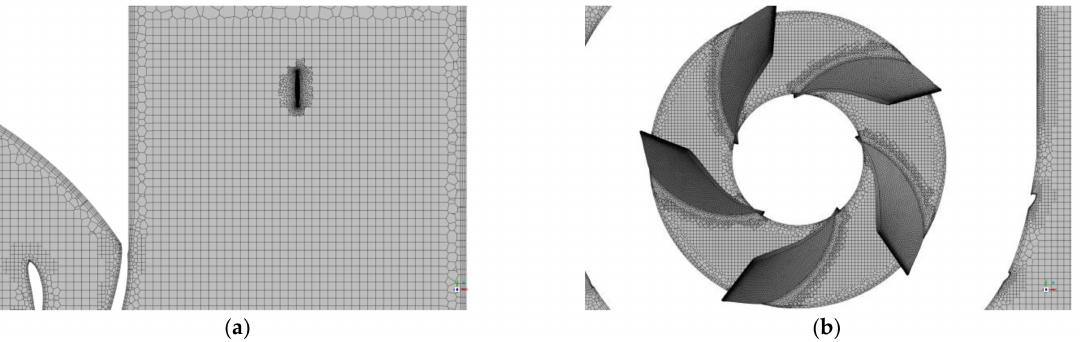
Figure 7. Indicative views of the overset mesh: ( a ) near the region of the tracked body (ellipsoid) ( b ) at the rotor blades. The overlap of the mesh zones is visible.